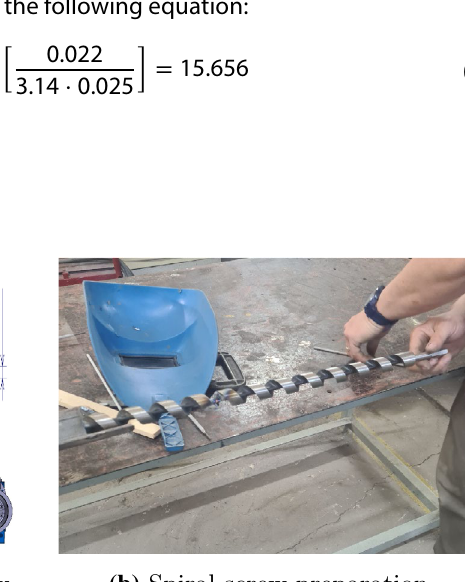
(a) Extrusion barrel and spiral screw. (b) Spiral screw